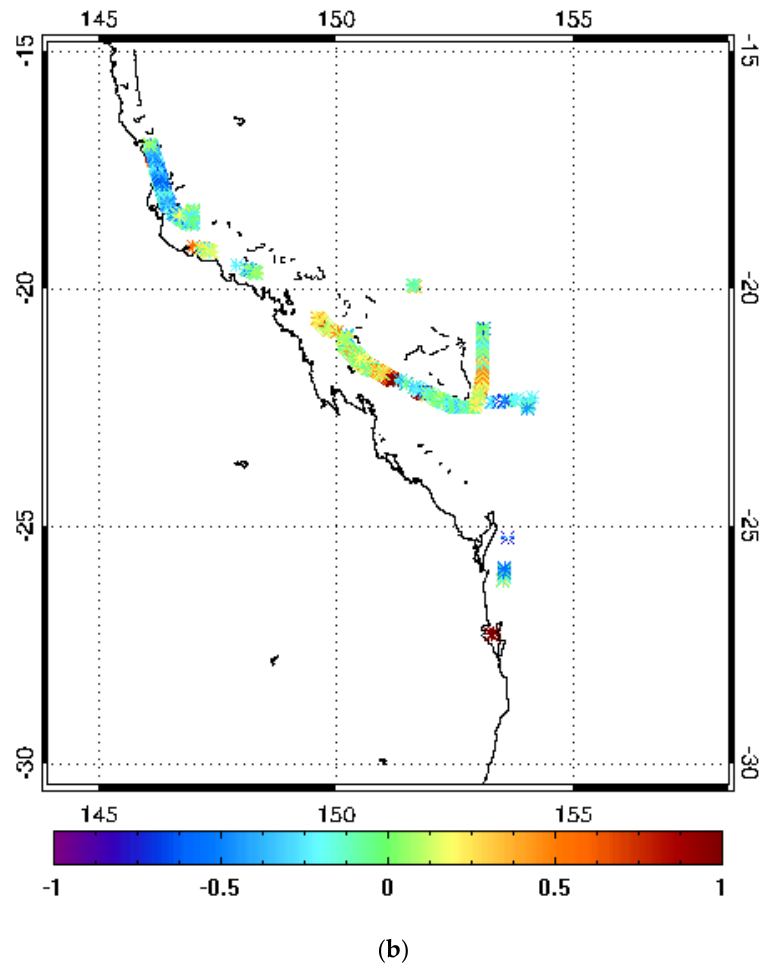
Figure 3. ( a ) Locations of matchups with the SST differences between Himawari-8 AHI skin SST and ISAR skin SST measurements (K); ( b ) Locations of matchups with the SST differences between Himawari-8 AHI skin SST and SBE 38 bulk SST measurements (K).